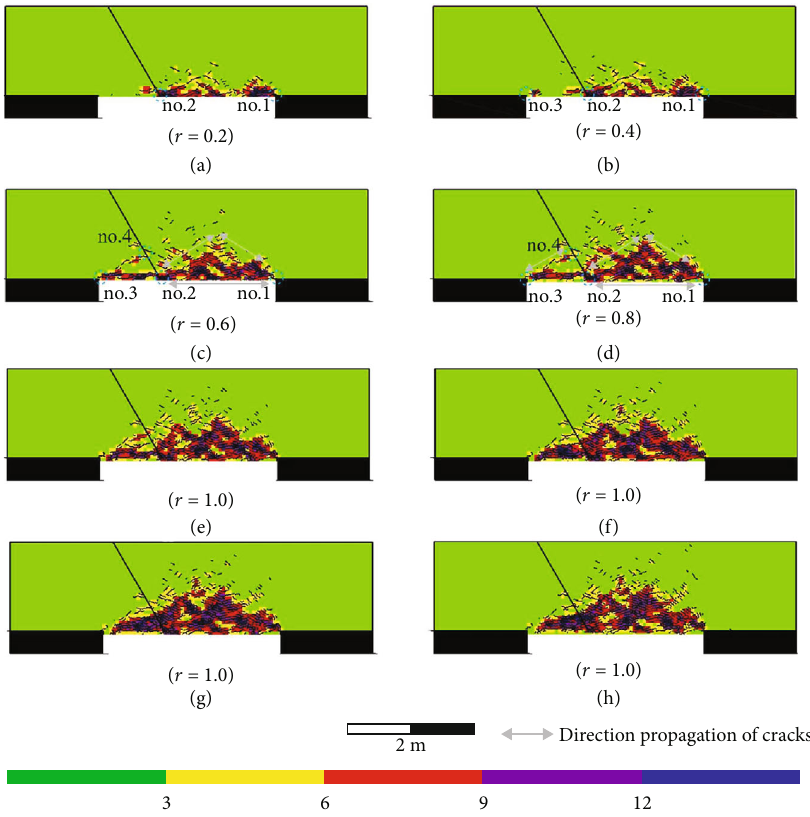
Figure 14: Cloud diagram of roof crack density under di ff erent stress release coe ffi